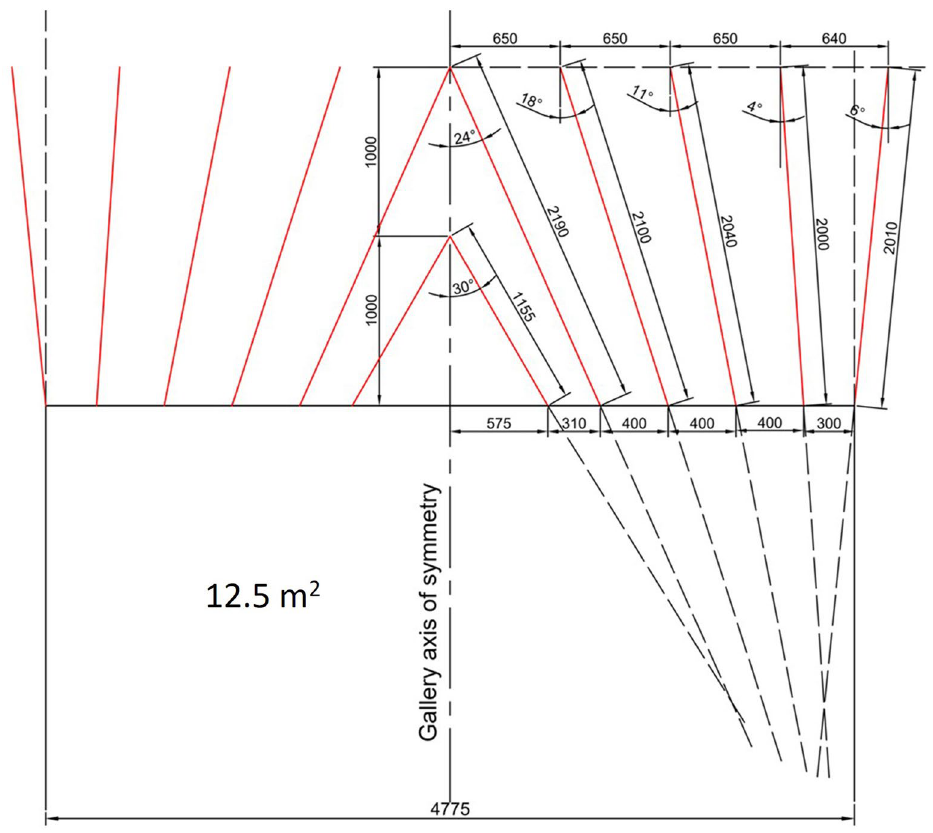
Figure 14. The arrangement of double V cut